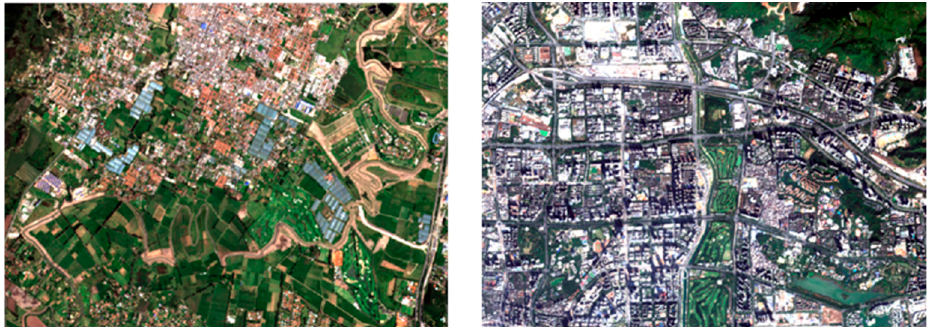
Figure 2. Samples from the Sentinel-2 dataset, 10 m spatial resolution (RGB).